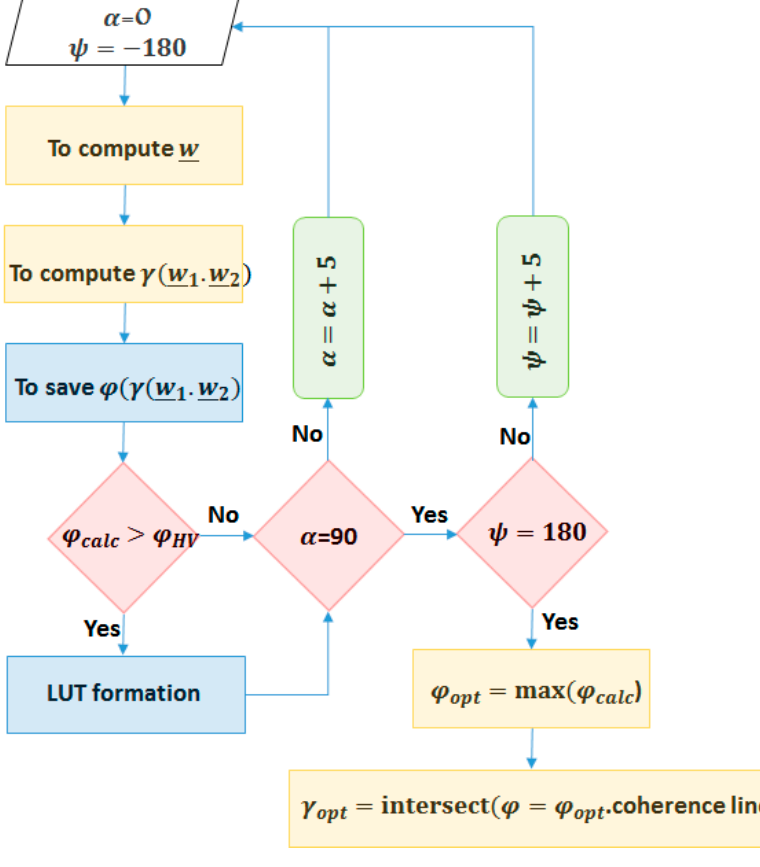
Figure 6. The flowchart of the volume coherence optimization method in the dual PolInSAR data.